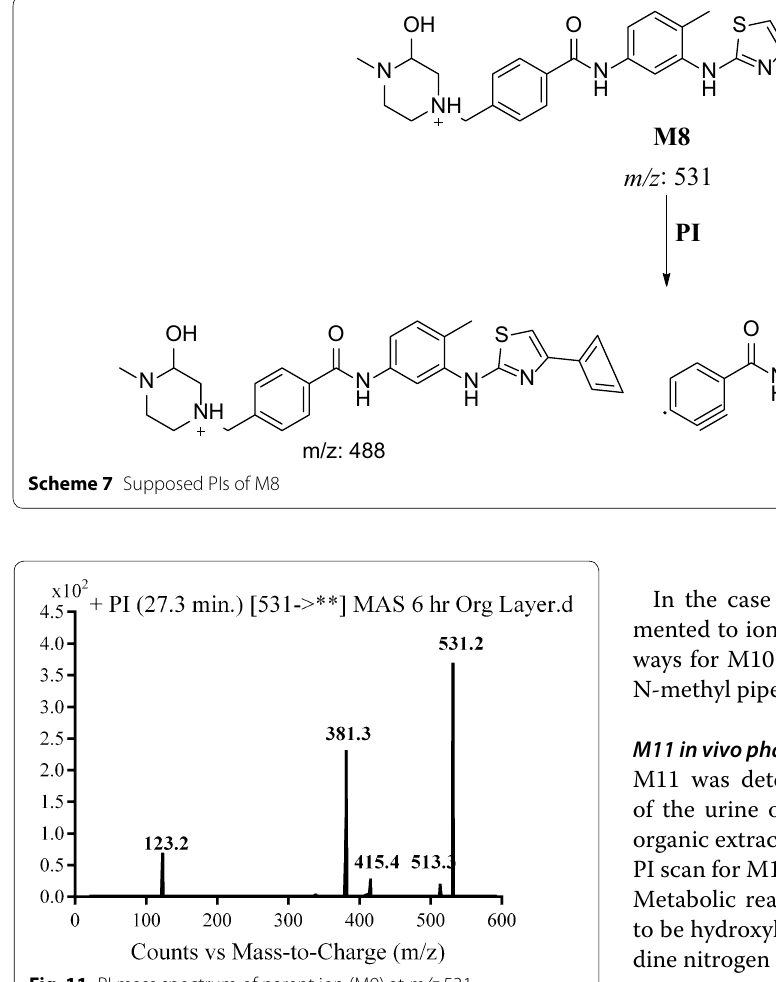
Fig. 11 PI mass spectrum of parent ion (M9) at m/z